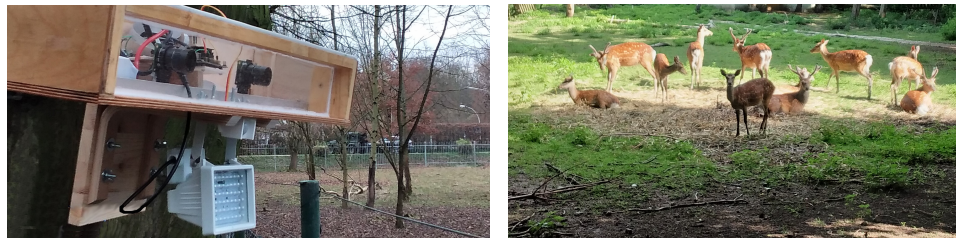
Figure 1. Introducing the SOCRATES camera trap system located in the wildlife park Plittersdorf located in Bonn, Germany, showing European fallow deer (Dama dama) and Sika deer (Cervus nippon).